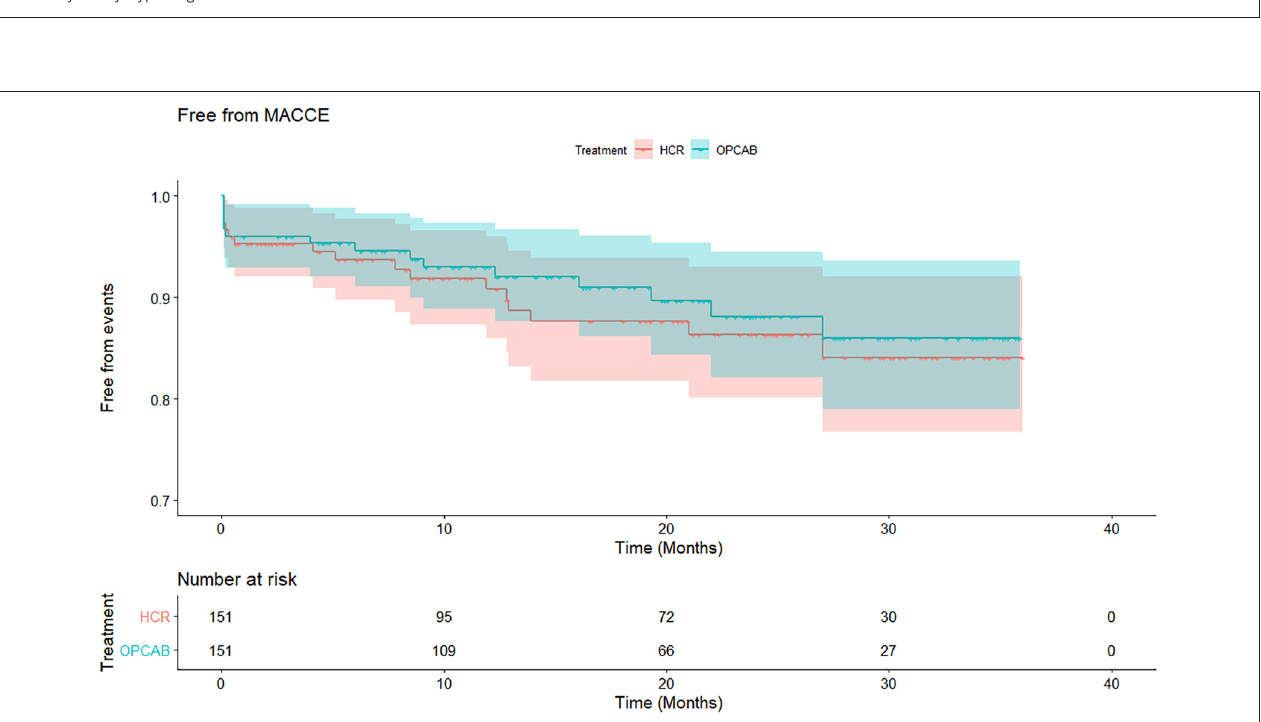
FIGURE 3 | Cumulative free from major adverse cardiovascular and cerebrovascular events (MACCE) rate in HCR and OPCAB group. Kaplan–Meier curve estimates similar cumulated free from MACCE rate in HCR and OPCAB groups (84.1 vs. 86%, p = 0.59) during the follow-up. MACCE, major adverse cardiovascular and cerebrovascular events; HCR, hybrid coronary revascularization; OPCAB, off-pump coronary artery bypass grafting.